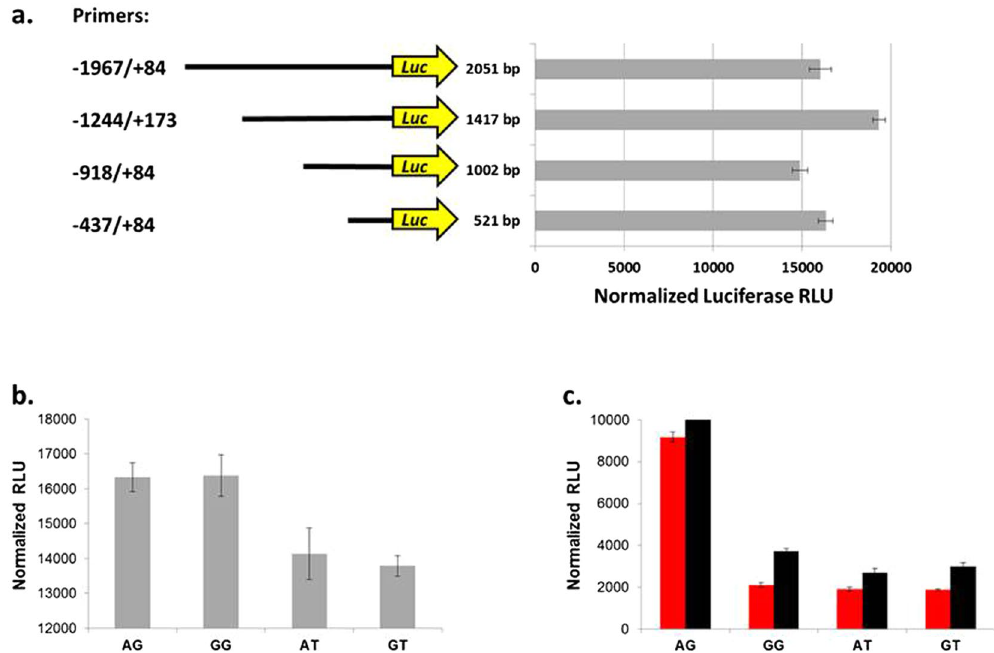
Figure 2. Relative strength of the putative promoter region of the blw gene. ( a ) Four different lengths of the blw -promoter region harboring the AG haplotype were cloned in the pGL3-basic vector and expressed in Drosophila S2 cells. Primer locations are indicated with respect to the transcriptional start site of the blw gene (see Fig. 1). Black lines represent the promoter length and the yellow arrow represents the luciferase reporter gene. ( b ) The 521 bp blw -promoter region harboring the AG, GG, AT and GT haplotypes were cloned in the pGL3-basic vector and expressed in Drosophila S2 cells. ( c ) The same promoters were expressed in flies using the Gal4-UAS binary expression system. For each experiment, protein lysates were extracted and luciferase expression was measured and normalized (relative light units; RLU). Gray bars represent the Drosophila S2 cells (Panels a and b). Female flies are represented by red bars and males by black bars (Panel c). Error bars are standard errors of the